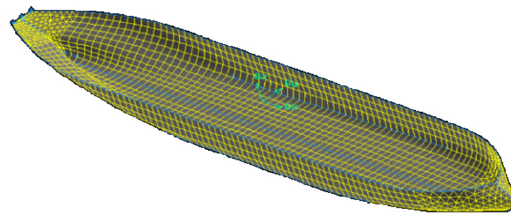
Figure 4. Grid diagram of the KVLCC2 ship surface.